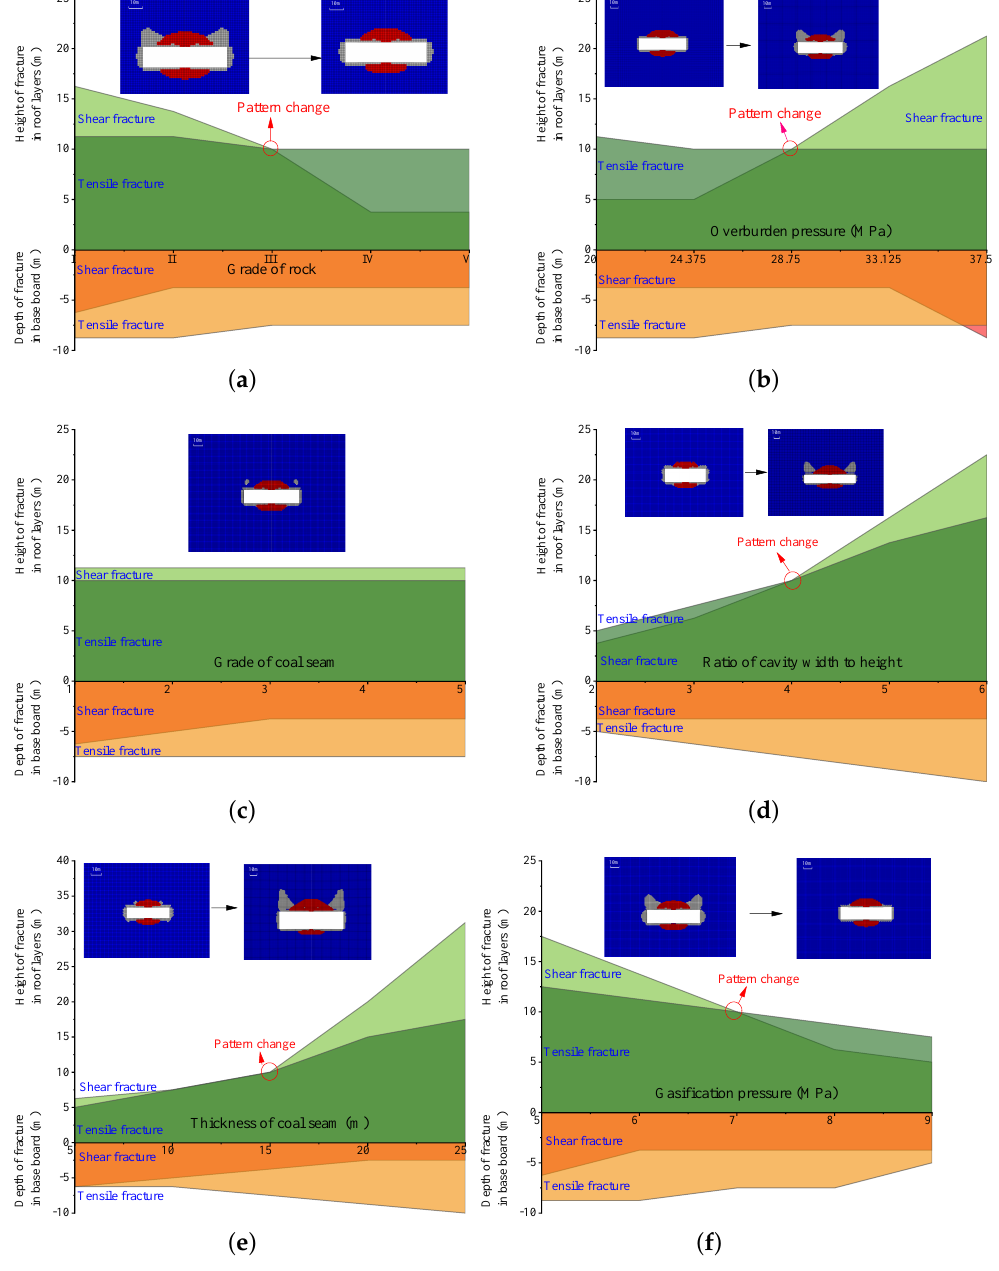
Figure 6. Evolution of fracture height with variable levels in ( a – f ) grade of rock, overburden pres- sure, grade of coal seam, ratio of cavity width to height, thickness of coal seam, and gasification pressure,